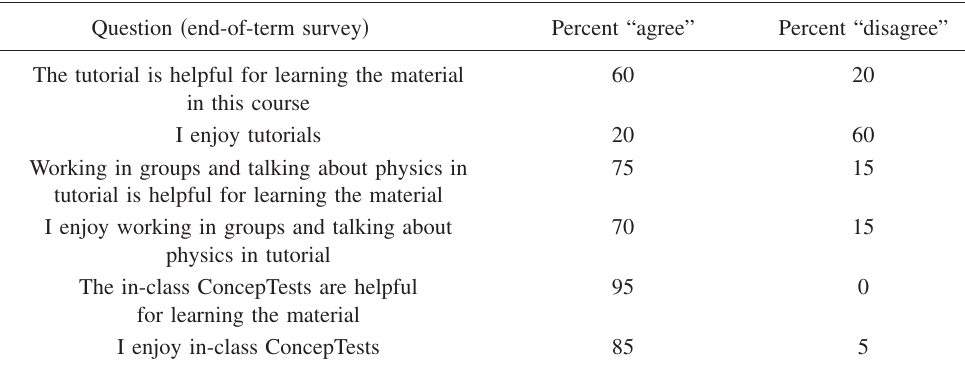
TABLE III. Student responses to end-of-term online survey questions, rounded to nearest 5%. Questions were asked on a five-point Likert scale; “agree” in table corresponds to both “4” and “5.” Totals do not sum to 100 because neutral “3” is a valid response.